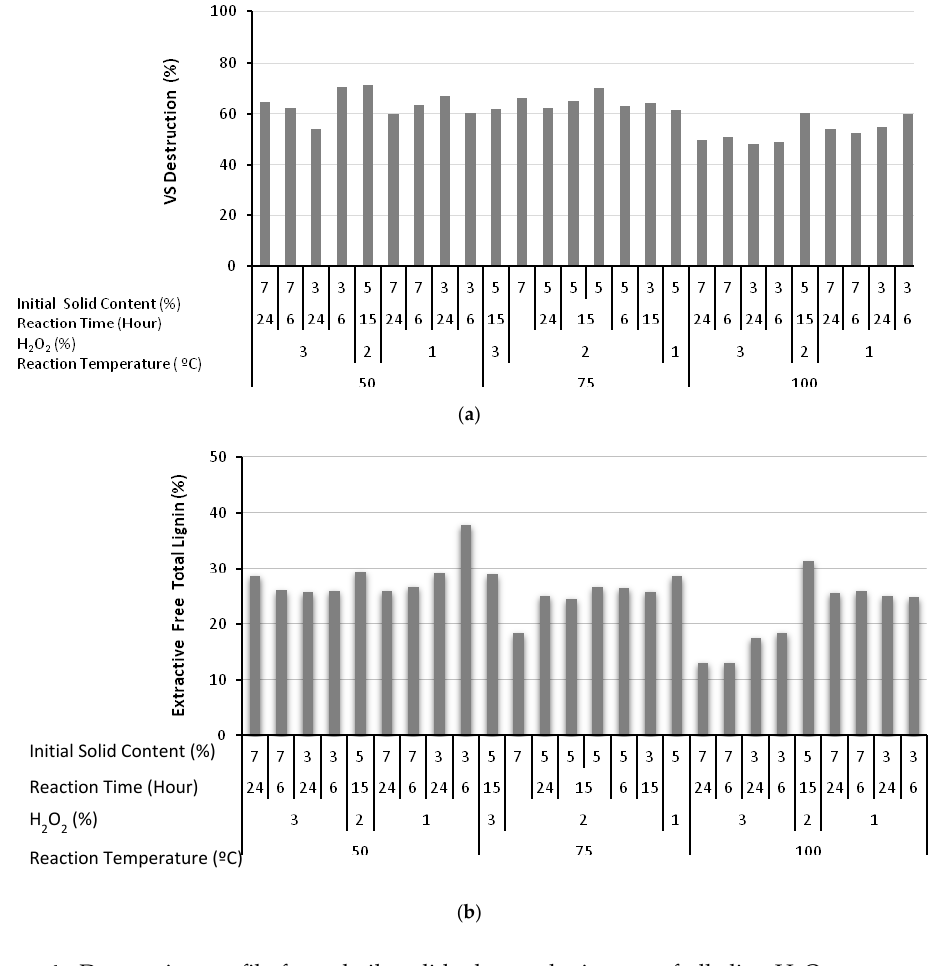
Figure 4. Destruction profile for volatile solids due to the impact of alkaline H 2 O 2 treatment ( a ). Experimental outcomes for the total lignin on an extractives free bases ( b ).